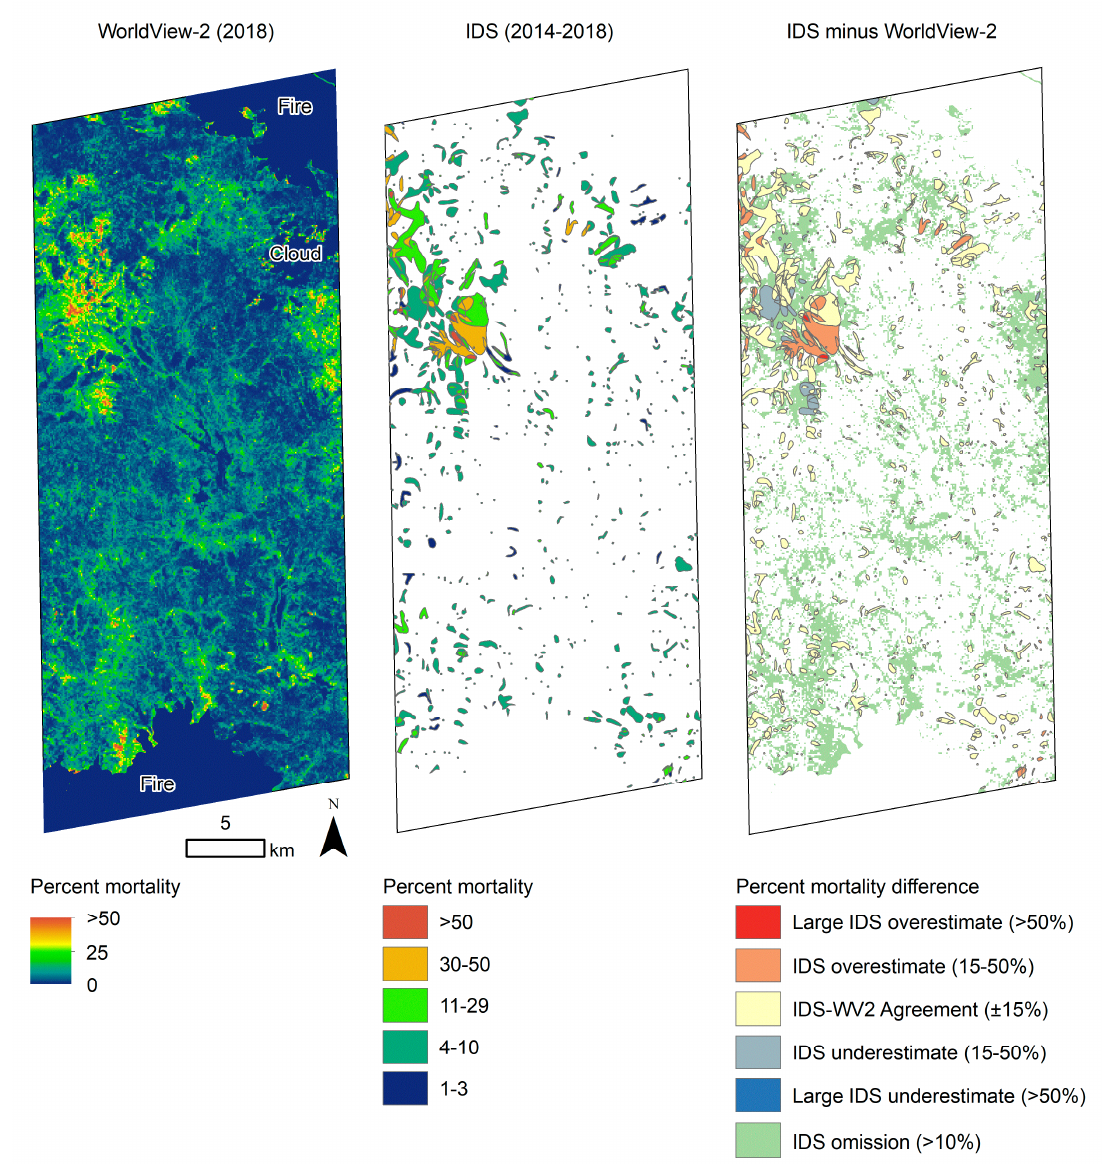
Figure 6. Comparison of percent mortality from WorldView-2 (1 September, 2018 imagery aggregated to 90-m pixel resolution to show percent mortality) and cumulative insect and disease survey (IDS) data. Overall patterns agree. In the difference map, warm colors indicate where the IDS estimated greater percent mortality, cool colors indicate where the IDS estimated less percent mortality, and green indicates where the IDS polygons did not occur but WorldView-2 detected >10% mortality.